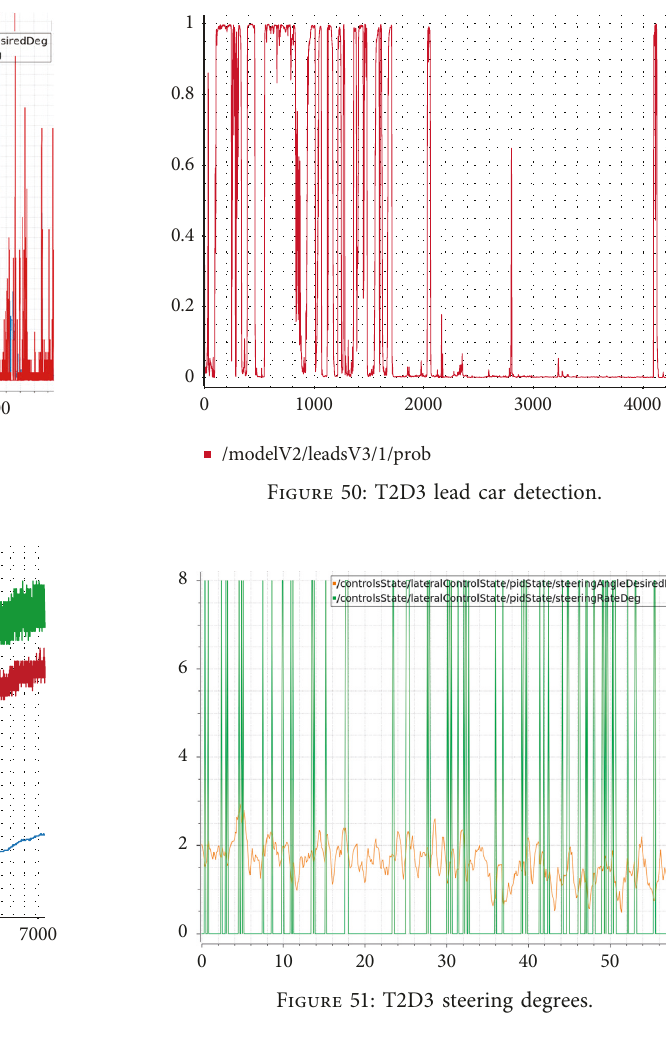
Figure 48: T2D1 lead car detection.